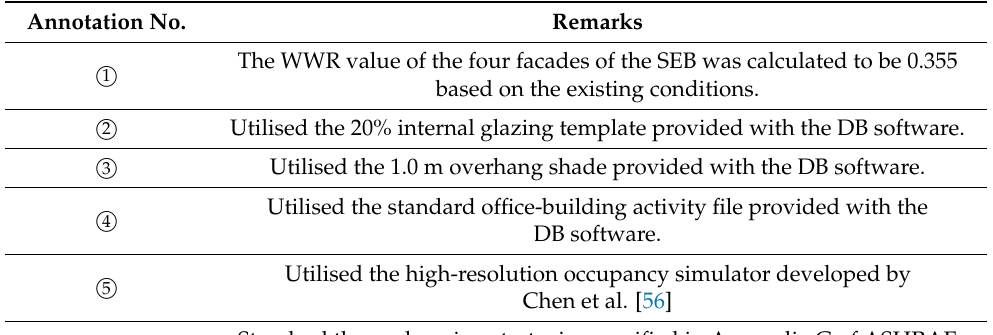
Table 3. Annotation of the energy-model resolution